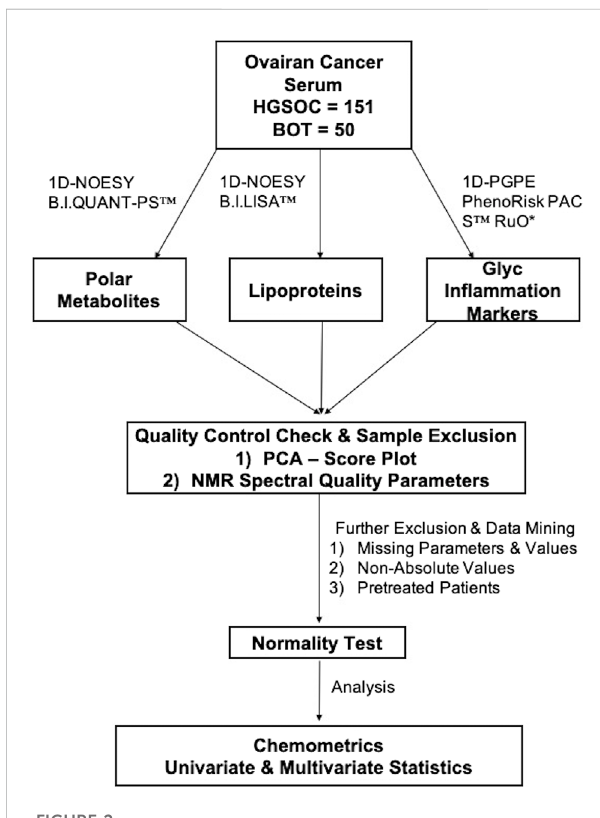
FIGURE 2 Metabolomics work fl ow. An overview of the data work fl ow in metabolomics for the identi fi cation of NMR-based alternations from borderlineovariantumorandhigh-gradeserousovariancancerserum